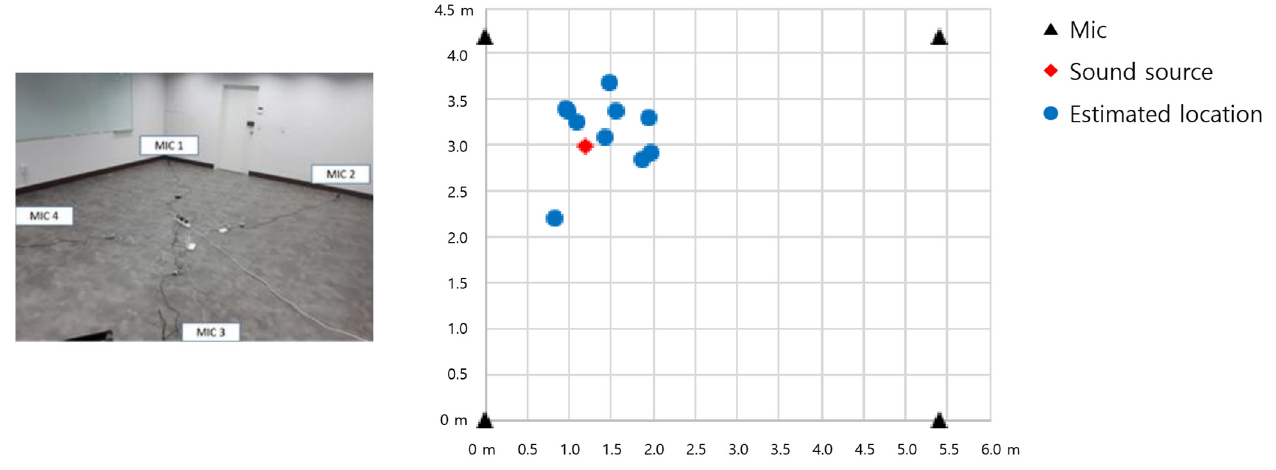
Figure 6. 2D localization results with a rectangular array.